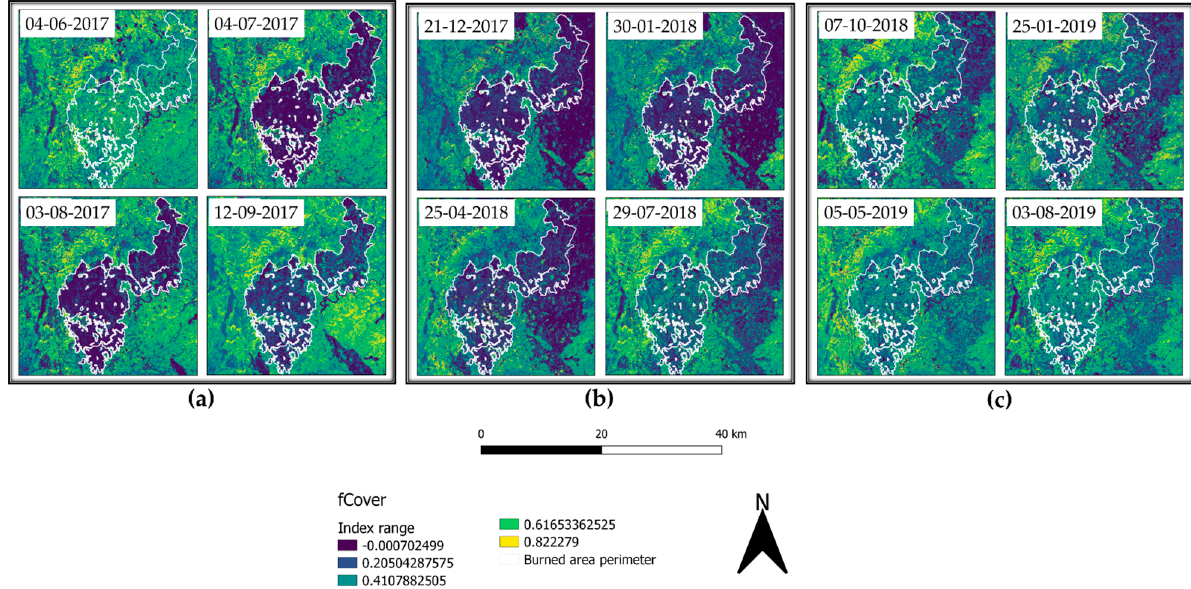
Figure 11. fCover representation from 4 June 2017 to 3 August 2019.